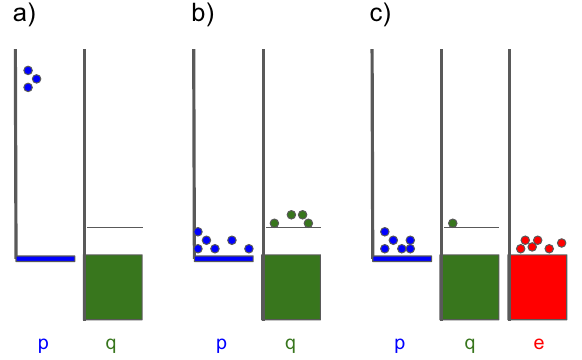
Fig. 1 Nonequilibrium phonon, quasiparticle, and electron excita- tions. a Schematic representation of the phonon (p) and quasi- particle (q) excitations after the radiation event, with only a few high-energy phonons. The vertical axis represents the state energy. b After relaxation, the phonon energy has down-converted to quasiparticle excitations in the superconductor and low-energy (subgap) phonons. About 57% of the initial energy remains in the quasiparticles. c With a normal metal structure, most of the energy has been channeled away from the superconductor and towards the normal metal electrons (e), which is designed not to affect the qubit.